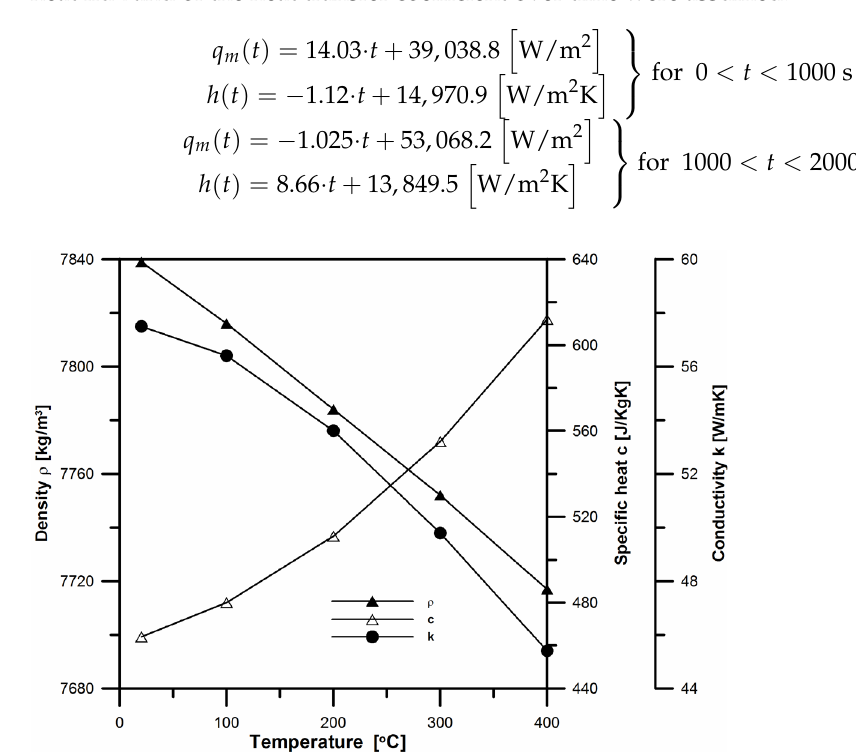
Figure 10. Material properties of 20 G steel.